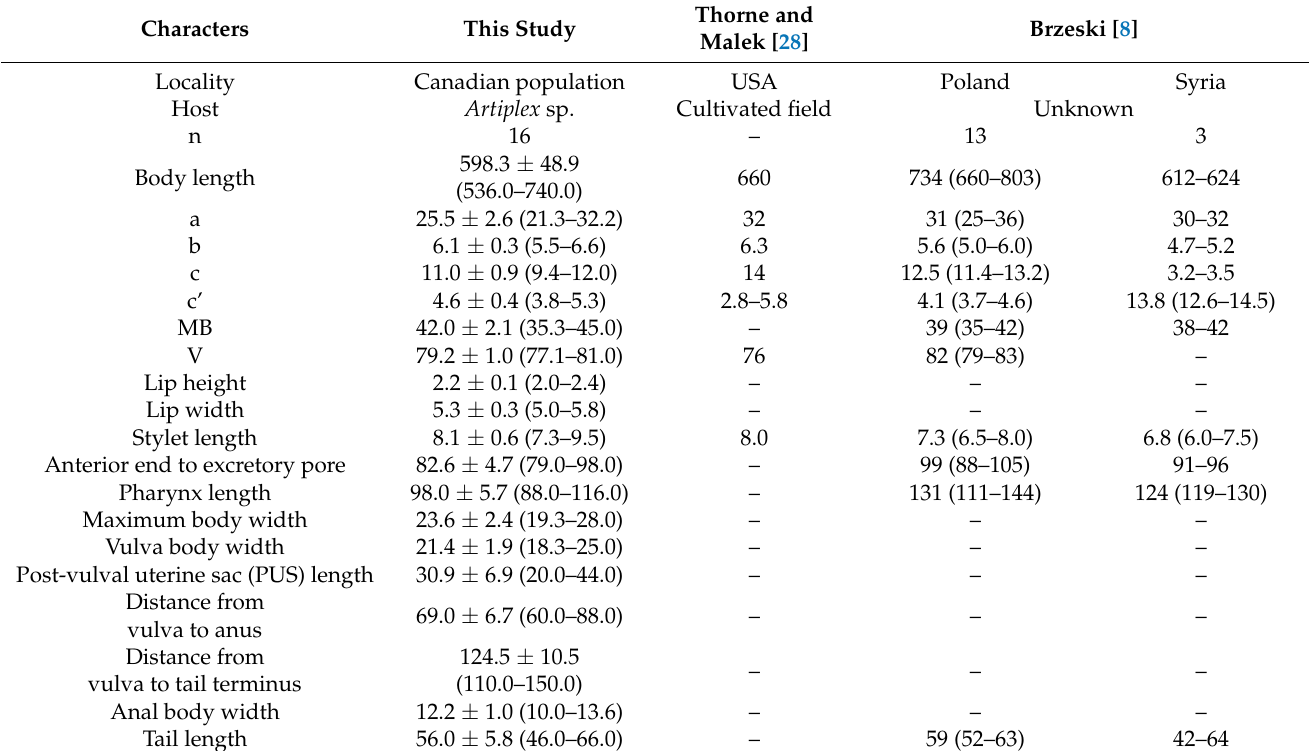
Table 1. Morphometrics of female Nothotylenchus medians examined in this study and from the original and other published descriptions. All measurements are in µ m and in the form: the mean ± standard deviation and/or the